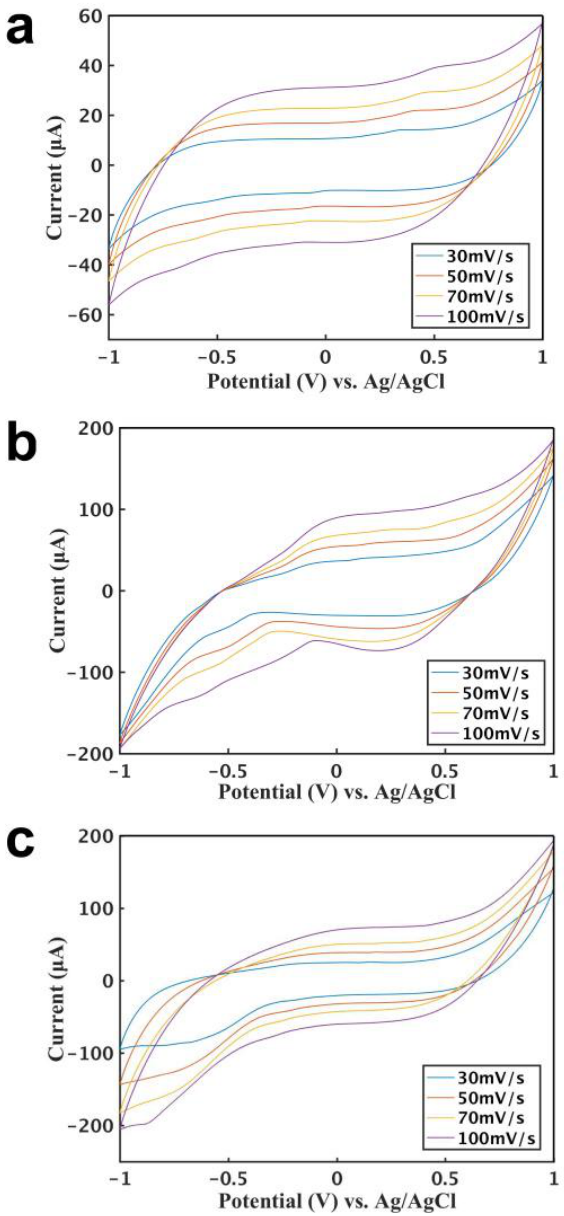
Figure 2. Characterization of the three styles of sensors for the CV curves at different scan rates. ( a ) Cyclic voltammetry curve for 2 mM H 2 O 2 based on two CNT electrodes. ( b ) Cyclic voltammetry curve for 2 mM H 2 O 2 by the sensor based on a CNT electrode and an Ag/AgCl electrode. ( c ) Cyclic voltammetry curve for 2 mM H 2 O 2 by the sensor based on two CNT electrodes and an Ag/AgCl electrode.